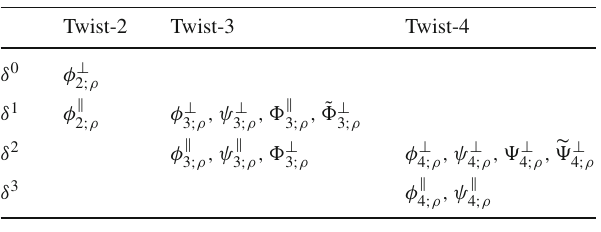
Table 1 The ρ -meson LCDAs with different twist-structures up to δ 3 [38], where δ (cid:9) m ρ / m c Twist-2 Twist-3